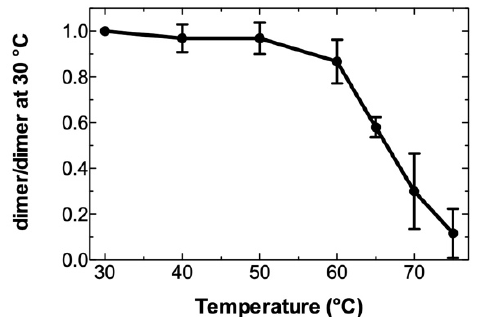
Figure 5. Thermal stability of the dimeric LdLB RNA. The melting curve was determined as described in Materials and Methods. Data are normalized according to the percentage of dimer at 30 ◦ C and result from three experiments. Error bars show standard deviations.